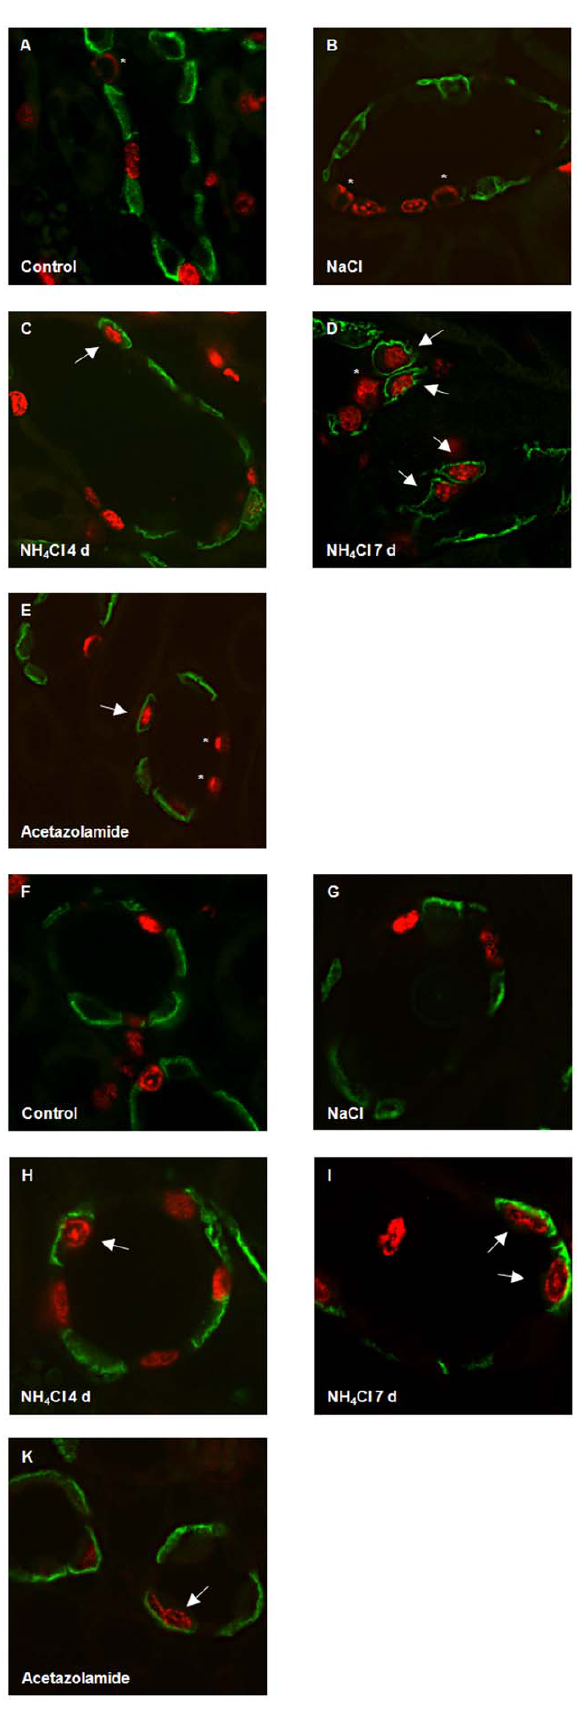
Figure 7. Proliferation of type A intercalated cells during metabolic acidosis. Kidney sections were stained with antibodies against AE1 (green), pendrin (red, asterisk), and BrdU (red nuclei). ( A–E ) Localization of BrdU positive cells in the CCD of control rats (A) or animals on NaCl for 7 days (B), NH 4 Cl for 4 or 7 days (C,D), or receiving acetazolamide for 10 days (E). BrdU colocalized with AE1 in NH 4 Cl or acetazolamide treated rats (arrows). ( F–K ) Colocalization of BrdU and AE1 staining (arrows) in OMCD intercalated cells in rats treated with NH 4 Cl (H, I) or acetazolamide (K) but not in control (F) or NaCl treated